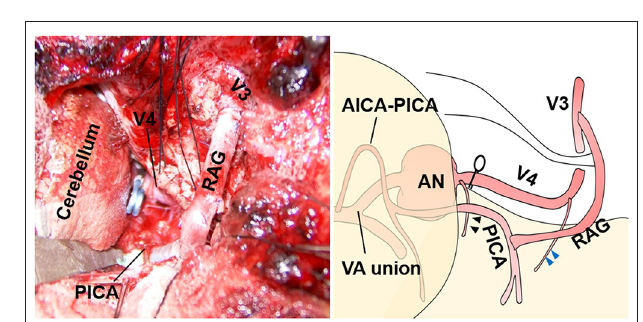
FIGURE 6 | Preoperative image examinations of case 3. (A) Magnetic resonance imaging. (B) Digital subtraction angiography.